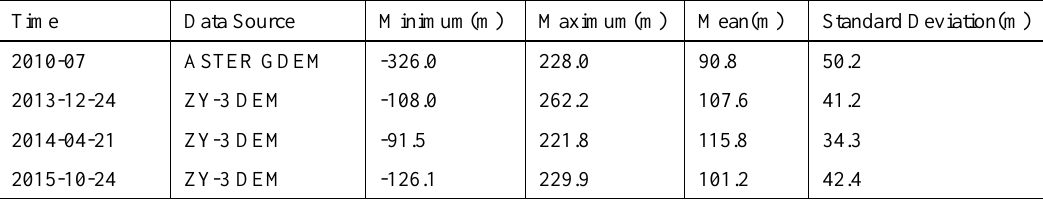
Table 2 Results of multi-temporal DEMs in the study area.